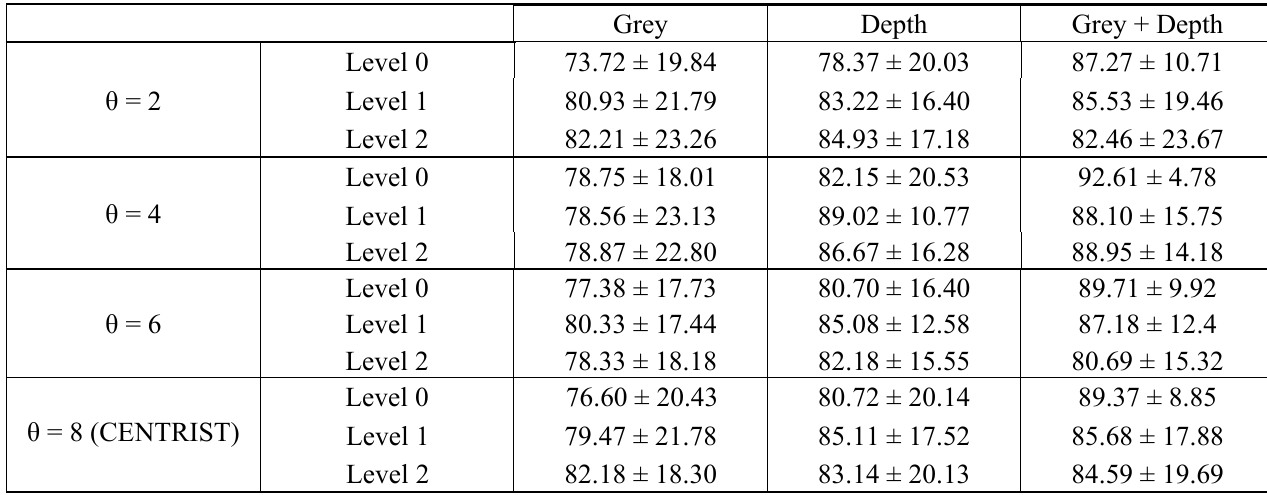
Table 4. Comparison of single and combined modalities. Results are shown as percentages together with standard deviations.